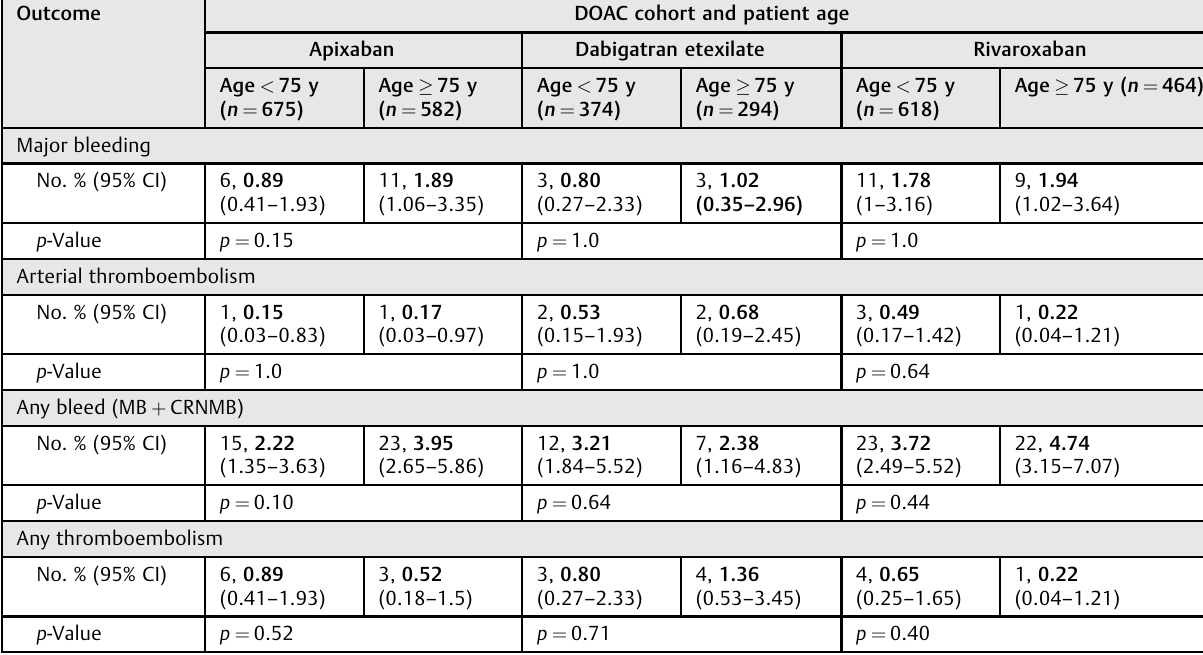
Table 6 Effect of patient age on clinical